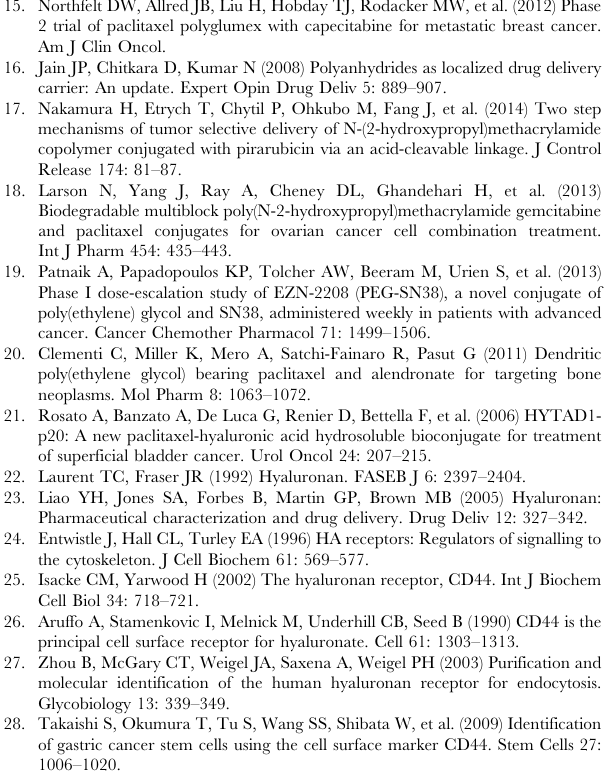
Figure S2 Kinetics of interaction between ONCOFID-P and tumor cell lines, in the presence of hyaluronidase. BODIPY-labeled ONCOFID-P was added to tumor cells for different time points (0.5, 1, 2, 5, 10 and 15 minutes); after extensive washing, samples were added with hyaluronidase for 4 hours or left untreated, and flow cytometry analysis was finally performed. A, whole kinetics of interaction at all time points tested. B, kinetics of the fluorescence intensity (geo mean) detected on tumor cells at the same time points analyzed as in A. Panels A and B report mean 6 SD of 3 independent experiments. Figure S3 Blocking of the ONCOFID-P-receptor inter- action by an anti-CD44 antibody. HT-29, MKN-45 and OE- 21 tumor cells were incubated with BODIPY-labeled ONCOFID- P alone (solid line) or in the presence of an anti-CD44 blocking mAb (dashed line), and analyzed by flow cytometry. Data at the upper-right corner of each panel report the respective geo mean values and the percentage of reduction induced by anti-CD44 mAb blocking treatment. Figure S4 BODIPY labeling does not alter ONCOFID-S activity. Representative tumor cell lines were incubated with escalating concentrations of unlabeled and BODIPY-labeled ONCOFID-S, and the resulting growth inhibition was evaluated by ATPlite assay. Unlabeled and labeled bioconjugates showed fully overlapping dose-response curves. The values of IC 50 reported were calculated from these semi-logarithmic dose- response curves by linear interpolation.